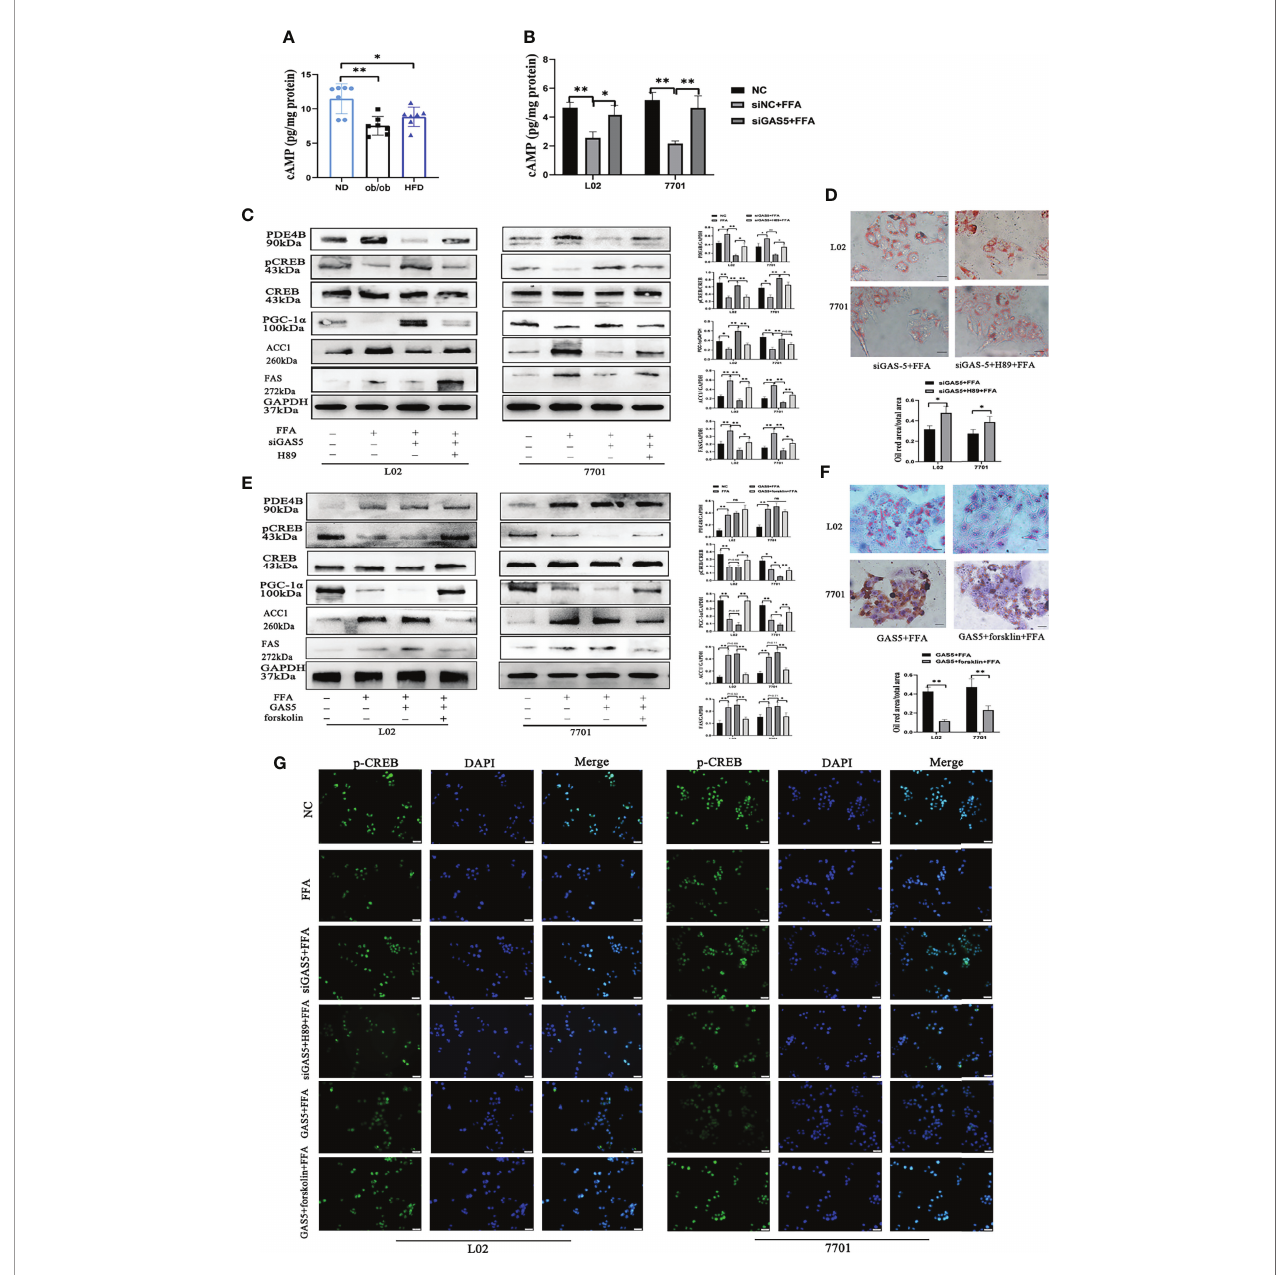
FIGURE 7 | Long non-coding RNA growth arrest speci fi c 5 (GAS5) regulates cAMP/CREB pathway through phosphodiesterase-4B (PDE4B). The cAMP levels in liver tissues (A) and cells treated with free fatty acid (FFA) or siGAS5 plus FFA (B) . Protein expression of PDE4B, p-CREB, CREB, PGC-1 a , ACC1 and FAS in cells treated with FFA after transfection with siGAS5 or siGAS5 plus H89 (C) . Oil red staining of cells transfected with siGAS5 or siGAS5 plus H89 followed by FFA treatment (Original magni fi cation, ×400) (D) . Protein expression of PDE4B, p-CREB, CREB, PGC-1 a , ACC1 and FAS in cells treated with FFA after transfection with GAS5 or GAS5 plus forskolin (E) . Oil red staining of cells transfected with GAS5 or GAS5 plus forskolin followed by FFA treatment (Original magni fi cation, ×400) (F) . Immuno fl uorescence of p-CREB in cells with different treatment (G) . Data are expressed as mean ± standard error of mean. * P < 0.05 and ** P < 0.01, n =